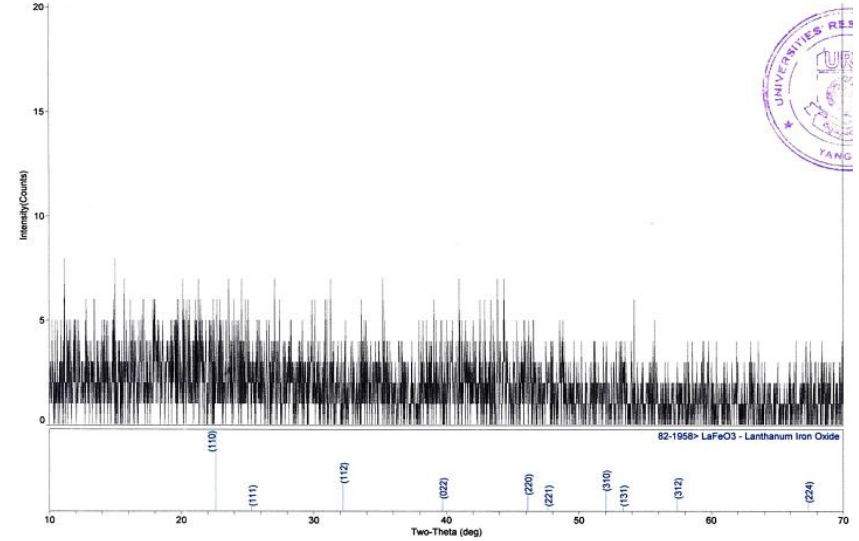
Figure 2. XRD pattern of LaFeO 3 xerogel powder